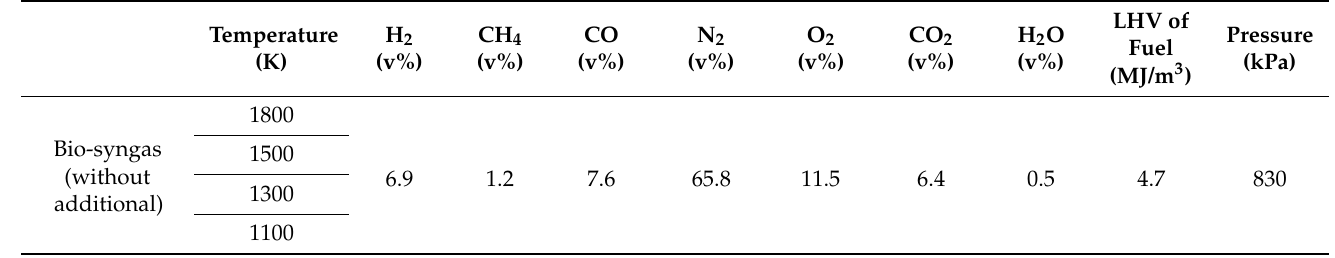
Table 6. Calculation conditions of mixture reaction rate (pressure is constant). The temperature is changed.